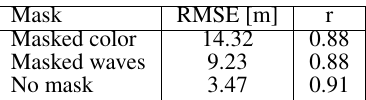
kinematics-based methods, C-DSPEB and H-DSPEB show clear sensitivity to the effect of turbidity on background